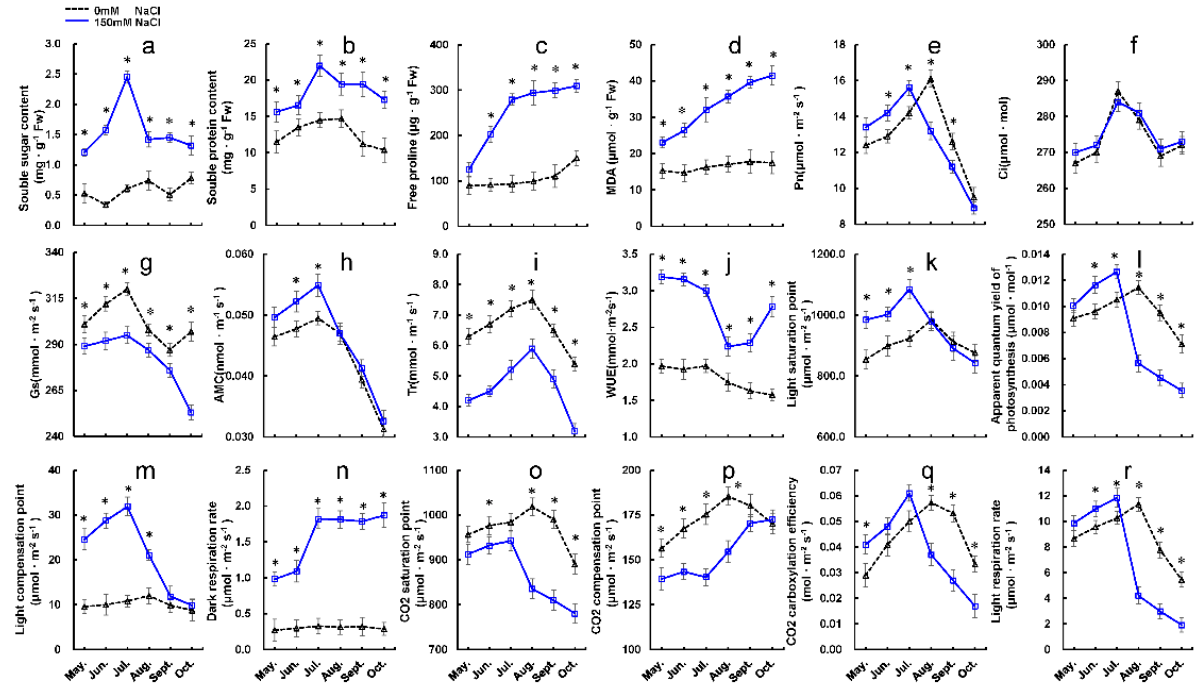
Figure 3. Physiological and photosynthetic changes in Upu11 under 0 mM and 150 mM NaCl treatments. ( a – d ) Changes in physiological parameters of protective enzymes, including ( a ) SS, ( b ) SP, ( c ) PRO, and ( d ) MDA; ( e – j ) changes in photosynthetic parameters, including ( e ) Pn, ( f ) Ci, ( g ) Gs, ( h ) AMC, ( i ) Tr, and ( j ) WUE; ( k – n ) changes in light response parameters, including ( k ) Lsp, ( l ) AQE, ( m ) Lcp, and ( n ) Rd; ( o – r ) changes in photosynthetic CO 2 response curve parameters, including ( o ) CSP, ( p ) CCP, ( q ) CE, and ( r ) Rl. Values represent means ± SD (n = 3), asterisks indicate p <0.05.